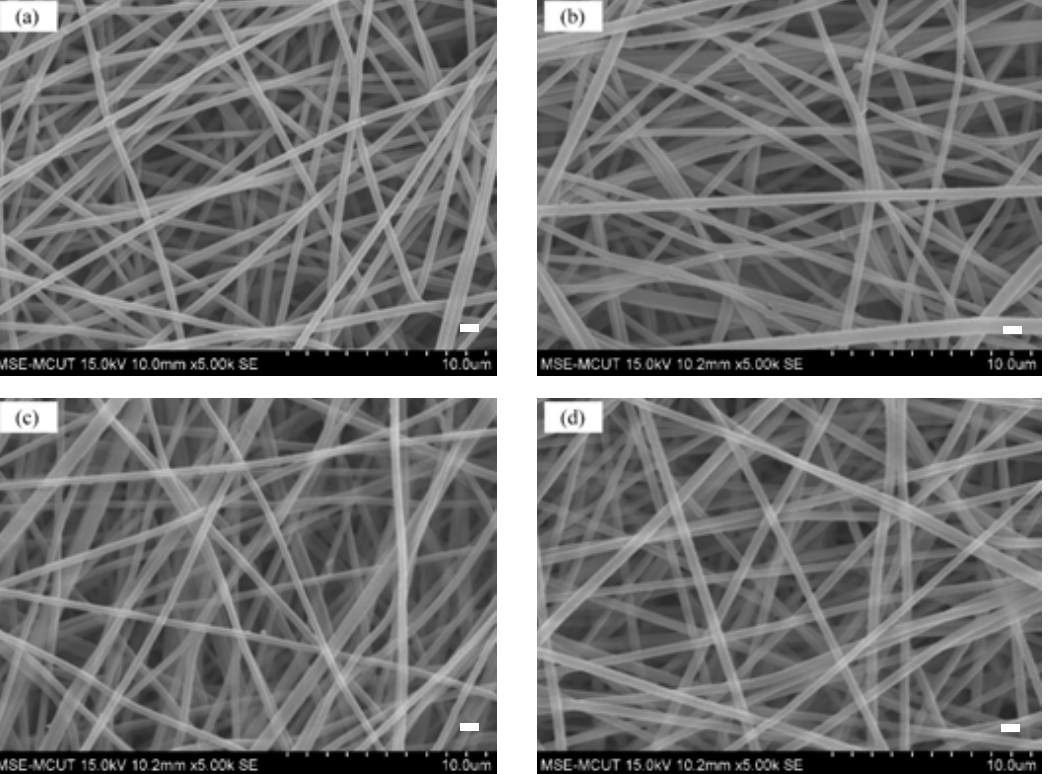
Figure 3. SEM images of ( a ) PAN, ( b ) P-COOH, ( c ) P-COOH-CS, and ( d ) P-COOH-CS-CEW.